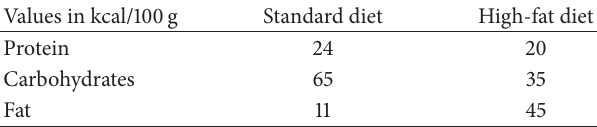
Table 1: Energy content of standard diet and high-fat